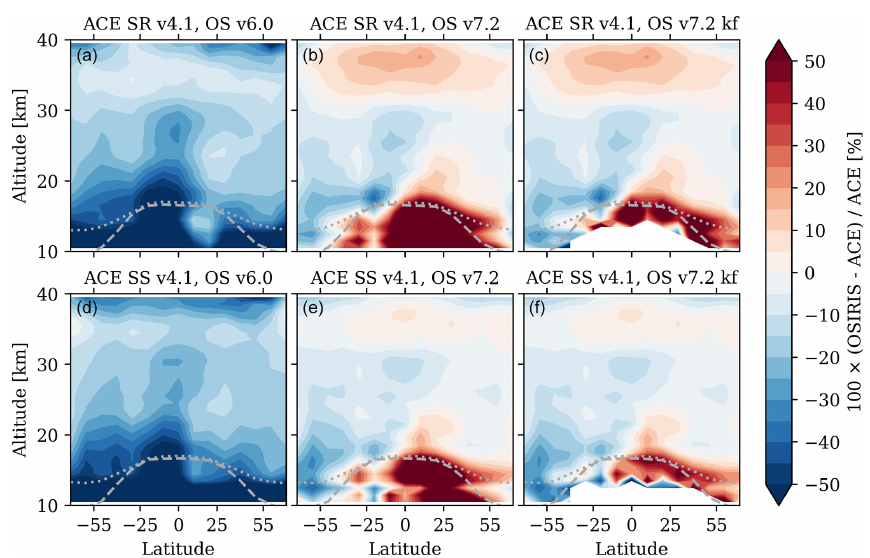
Figure 9. Mean percent difference between coincident profiles from ACE-FTS v4.1 and OSIRIS. (a–c) Sunrise occultations. (d–f) Sunset occultations. The last column is the same as the centre column, but with the averaging kernel filter applied to the OSIRIS NO 2 . In all panels the dashed line is the average tropopause altitude and the dotted line is the average 380K potential temperature altitude.